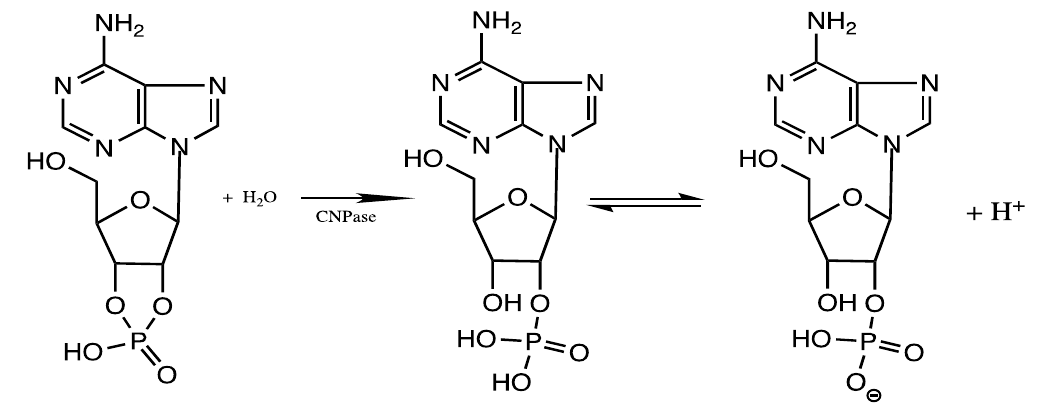
Figure 1. Reaction catalyzed by 2 ′ ,3 ′ -CNPase.